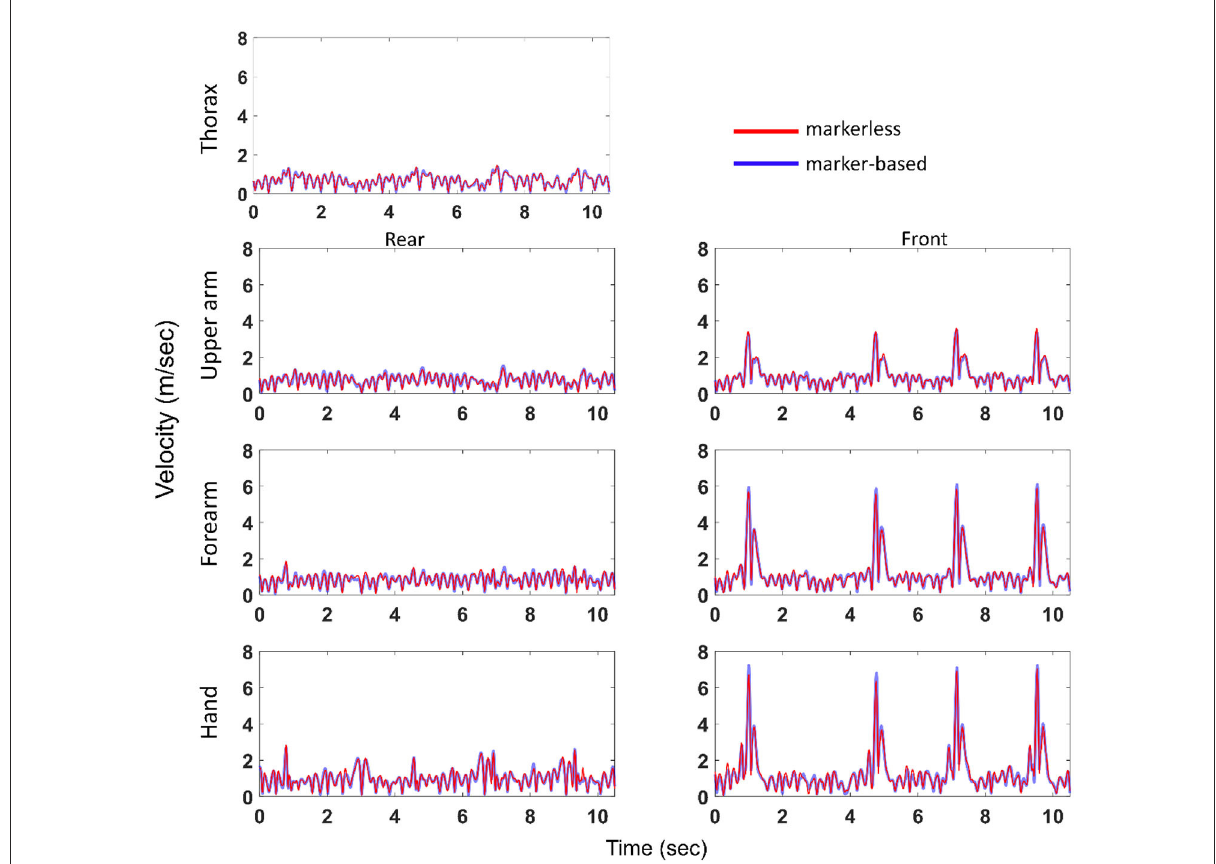
FIGURE4 Segment velocity magnitudes (ordinate) at the thorax, and at the front and rear upper arm, forearm, and hand computed with marker-based and markerless methods and represented over time (abscissa). Example shown for the second athlete and first boxing trial. Blue and red colors represent marker-based and markerless segment velocities,